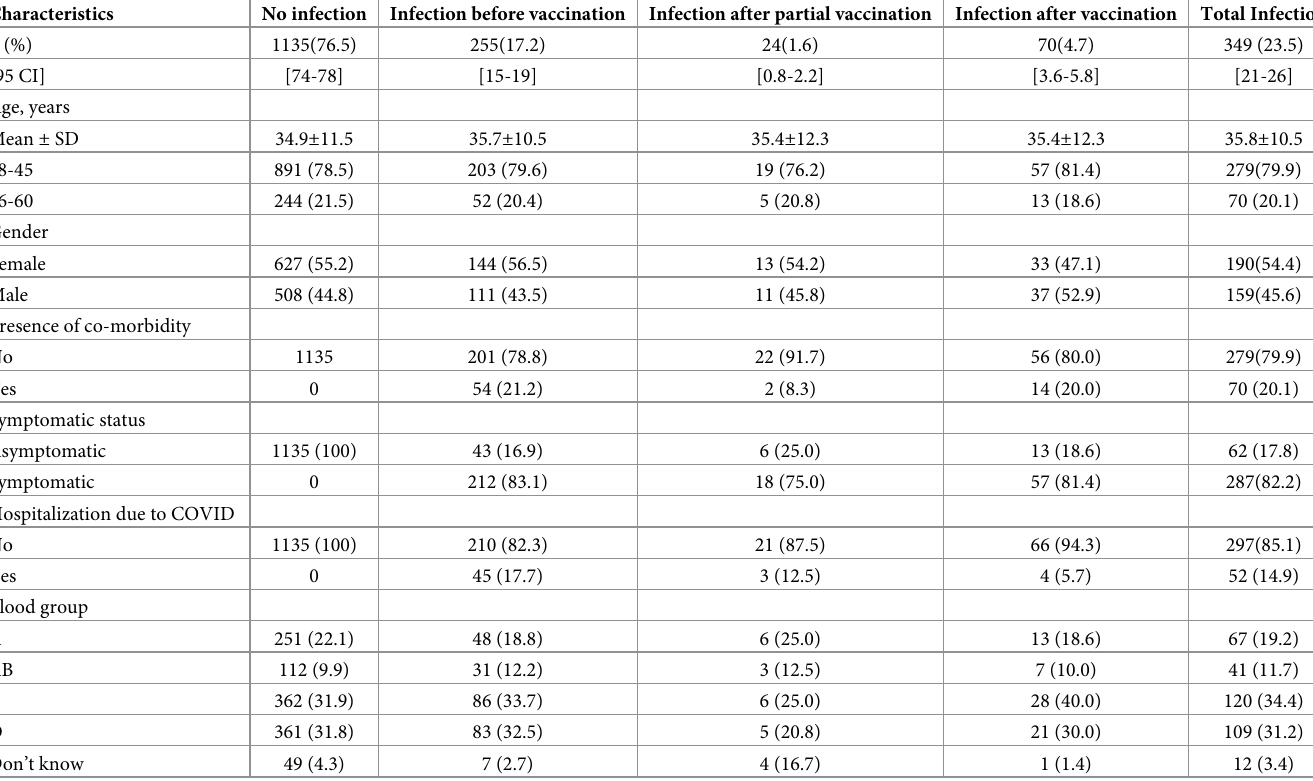
Table 2. Participant characteristics for COVID-19 infections in context of vaccination (N = 1484).